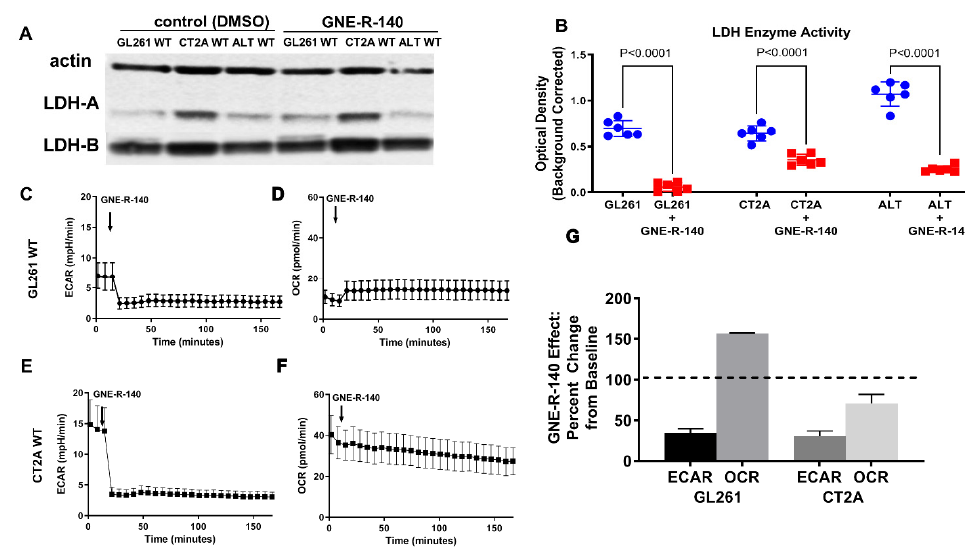
Figure 6. GNE-R-140 effects on GL261, CT2A and ALTS1C1 wild-type cells. Western blot expression of LDH-A and LDH-B proteins, in the presence of vehicle (DMSO) and drug (GNE-R-140, 10 µM) for WT murine glioma cells ( A ). Effect of GNE-R-140 (10 µM) on LDH enzyme activity of WT murine glioma cells ( B ). Effect of adding GNE-R-140 (10 µM) to the medium on ECAR—glycolysis ( C , E ) and OCR (OXYPHOS) ( D , F ) of GL261 WT cells ( C , D ), and of CT2A WT cells ( E , F ), respectively. Panel ( G ) shows the percentage change over 150 min in ECAR and OCR from baseline (100%) for GL261 and CT2A WT cells, when treated with GNE-R-140. Mean ± SEM. The native Western blot for Panel A is shown in the Supplement (Figure